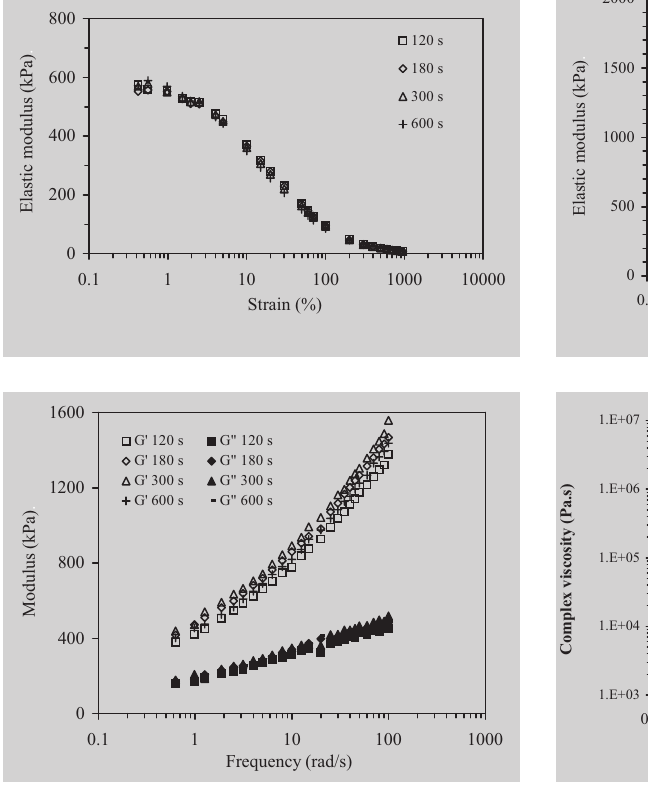
Figure 7 (left above): Elastic modulus, G’, as a function of % deformation strain at the test frequency of 3.14 rad/s (Payne effect) in filled uncured CPE/NR blends with the various mixing time. Figure 8 (right above): Elastic modulus, G’, of filled uncured CPE/NR blends with various mixing time as a function of % deformation strain at low (1 rad/s) and high (100 rad/s) frequency. Figure 9 (left below): Elastic modulus, G’, and loss modulus, G’’, of filled uncured CPE/NR blends with various mixing time as a function of frequency. Figure 10 (right below): Complex viscosity, h *, of filled uncured CPE/NR blends with various mixing time as a function of fre-